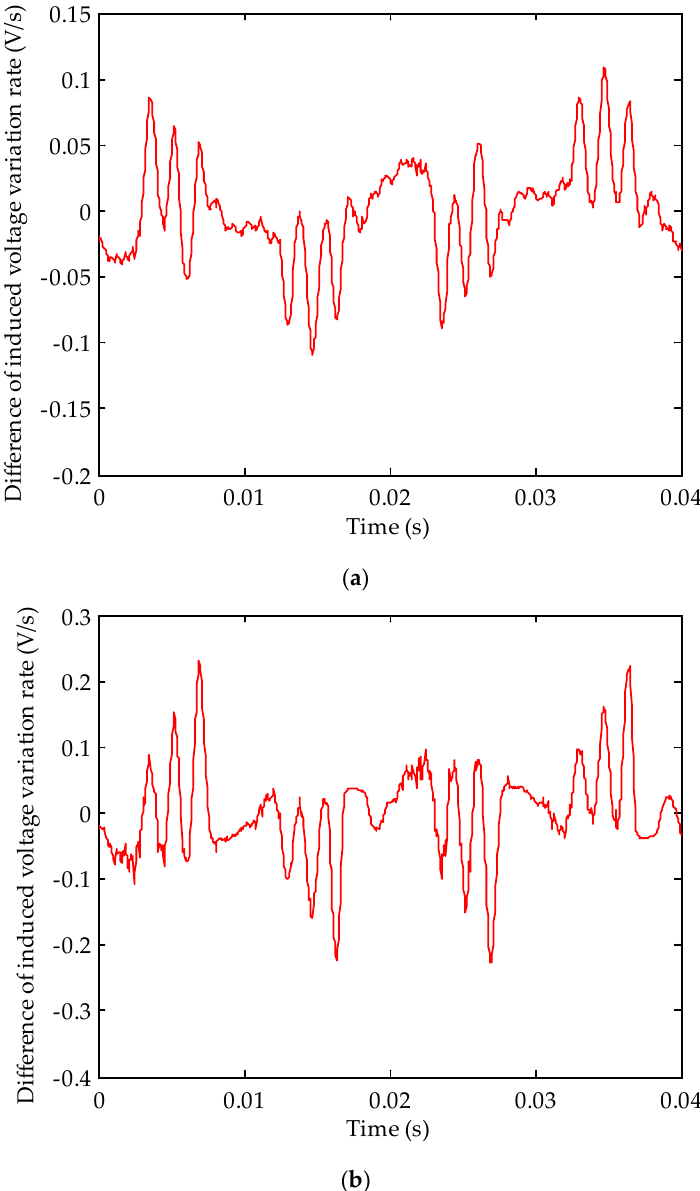
Figure 13. Difference in induced voltage change rates for both detection coils with a one-turn short circuit occurring separately in slots #3#, #6, and #9: ( a ) no-load; ( b ) rated load.